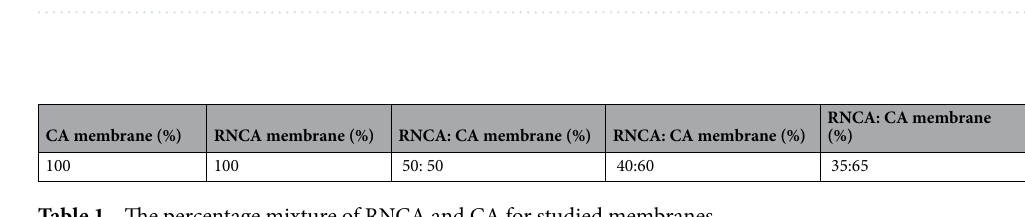
Figure 1. Steps of preparation of NCApowder. (( A ) Activation of Nanocellulose with acetic acid, ( B ) Complete acetylation, ( C ) Precipitation and drying of NCA).